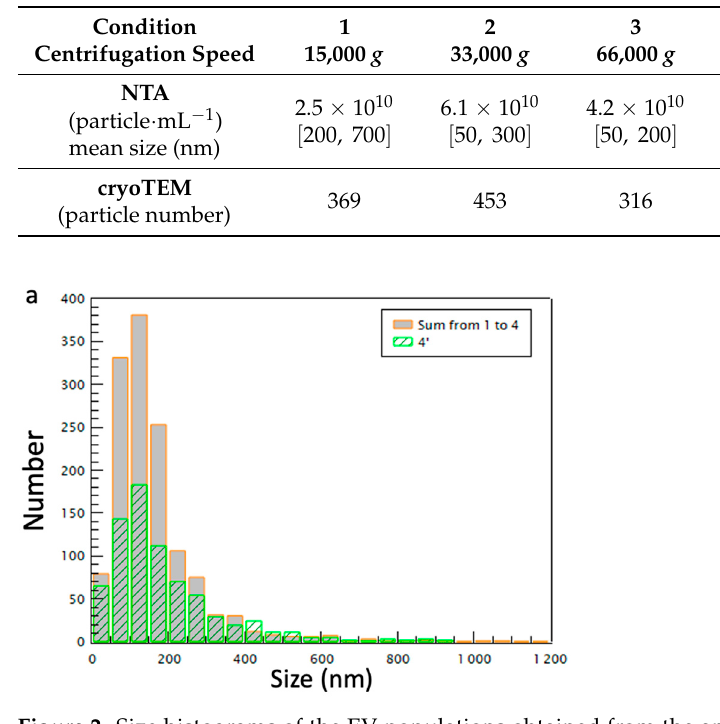
Figure 2. Size histograms of the EV populations obtained from the analysis of Cryo-TEM images using sequential centrifugation (sum of conditions 1–4, in orange) and one-step ultracentrifugation (condition 4 ′ , in green).